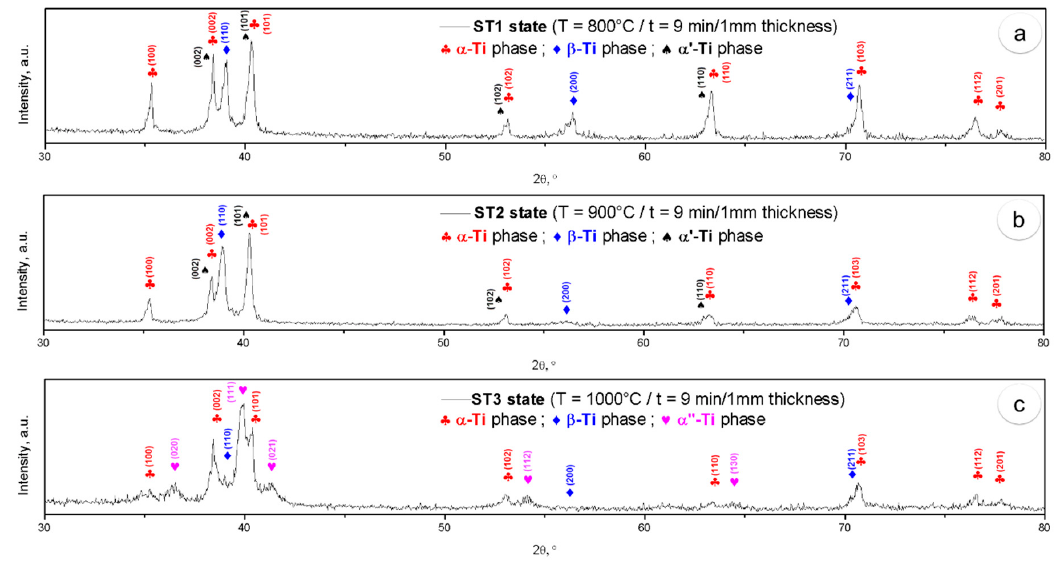
Figure 7. XRD spectra of ( a ) solution treated at 800 °C state (ST1); ( b ) solution treated at 900 °C state (ST2); ( c ) solution treated at 1000 °C state (ST3).